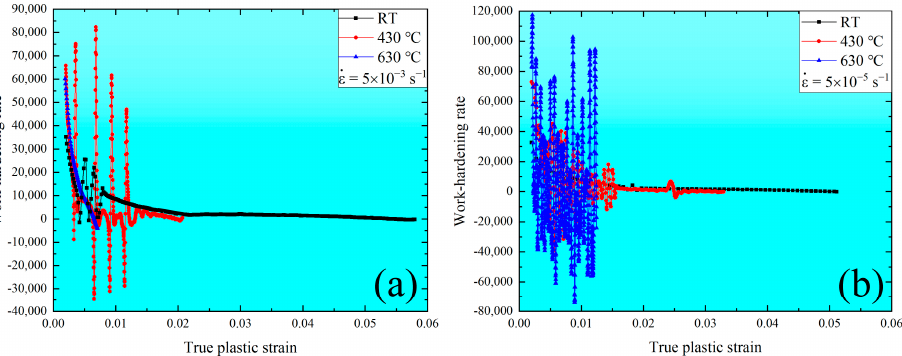
Figure 3. Work-hardening rate vs. true strain under different temperatures at the strain rate of 5 × 10 − 3 s − 1 at ( a ) and 5 × 10 − 5 s − 1 at ( b ). In order to study the effect of strain rate and temperature on the true stress–true strain behavior, several flow relationships in the literature can be used, such as